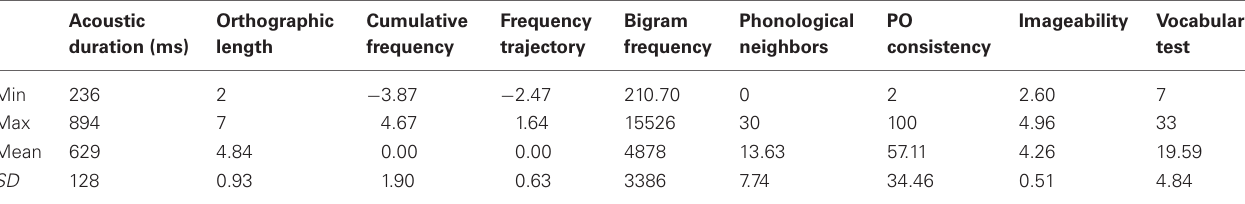
Table 1 | Statistical characteristics of the independent variables corresponding to the items used in the multiple regression